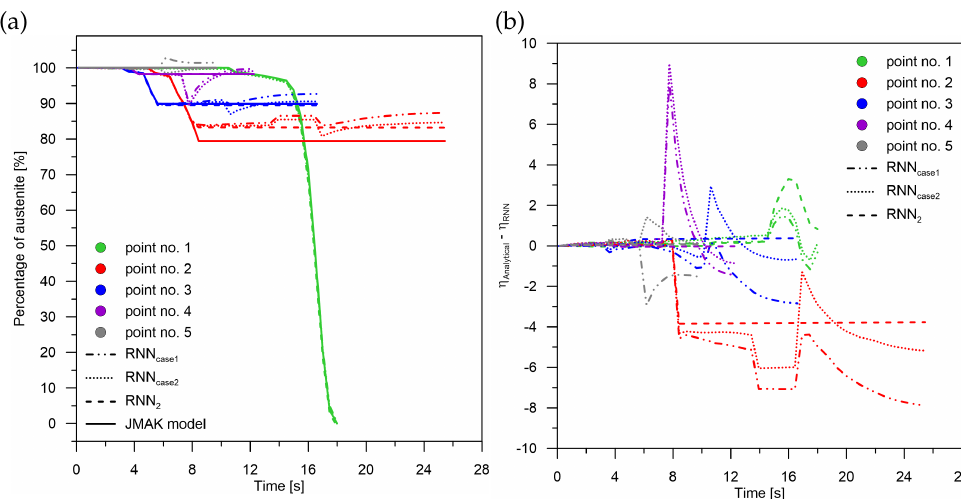
Figure 6. Phase transformation kinetics—case No. 1 and case No. 2. ( a ) Phase transformation RNN 2 . ( b ) The difference between JMAK and RNN models.